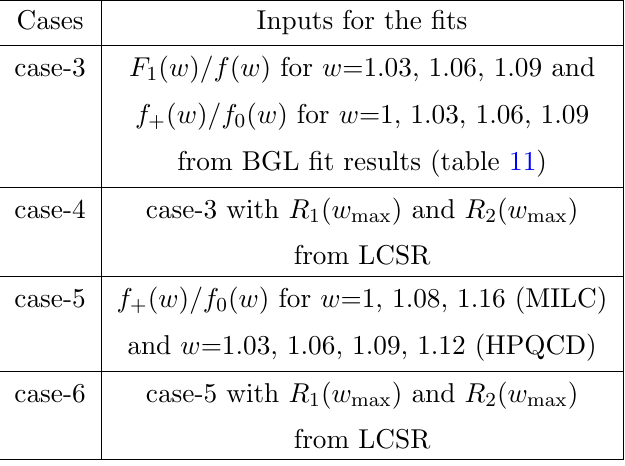
Table 13 . Di(cid:11)erent cases for the (cid:12)t of sub-leading Isgur-Wise